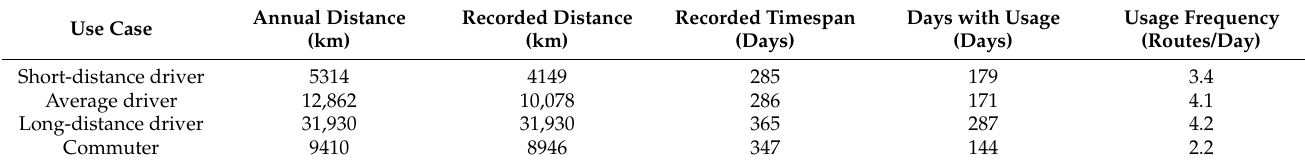
Table 1. Key parameters of selected use